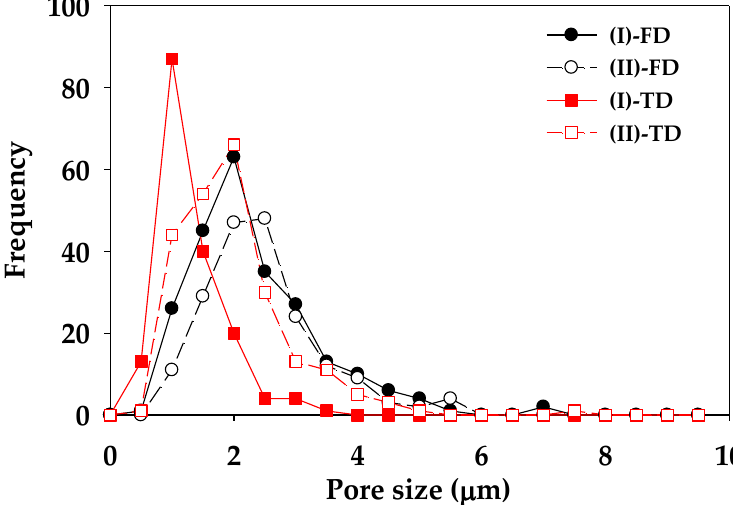
Figure 12. Pore size distribution curves of L5V5 at etching time of 7 days.